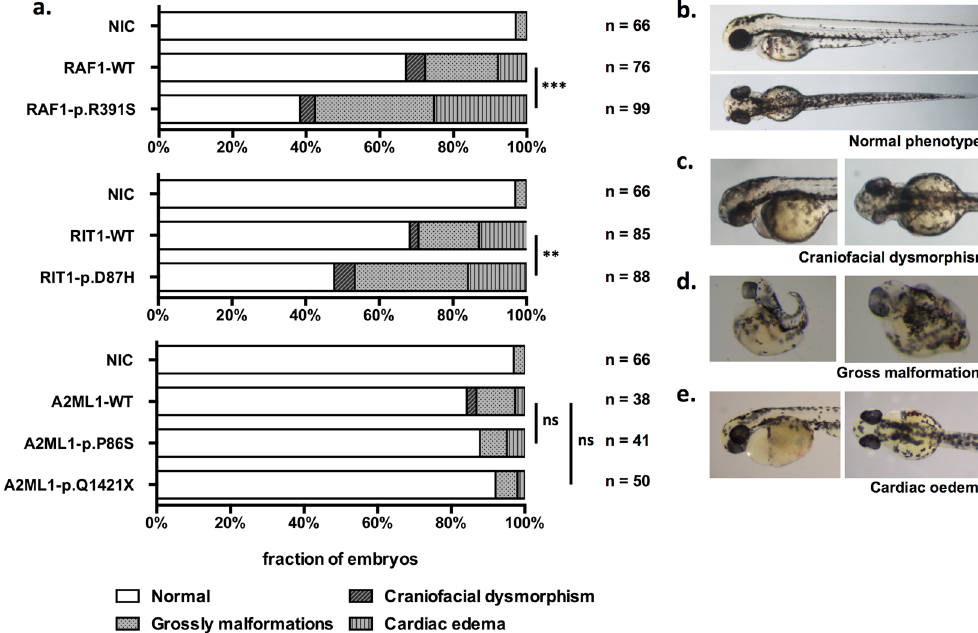
Figure 3. Transient expression of RNA transcripts in zebrafish embryos. The injection dosage of each RNA transcript was optimised for comparison ( RAF1 : 50 pg/embryo; RIT1 : 400 pg/embryo; A2ML1 : 200 pg/ embryo). A morphometric analysis was performed to compare the effect of the VUSs compared to the wild- type transcript at three dpf. Statistical significance was derived using a two-sided Fisher’s exact test to compare mutants with the corresponding WT. ** p < 0.01; *** p < 0.001; ns: not significant. NIC: No injection control;